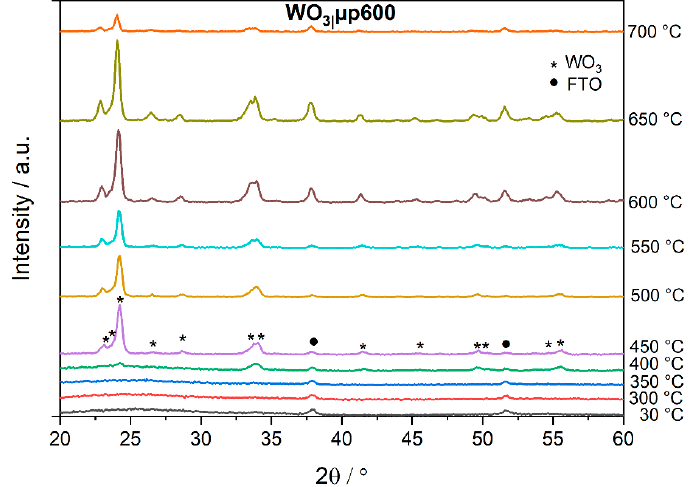
Figure 2. In situ GIXRD patterns of a WO 3| µp600 film that was annealed up to 700 °C with reflexes assigned to triclinic WO 3 (JCPDS: 83-0947) and FTO marked with asterisks and dots, respectively. Thermogravimetry (TG) of the dried precursor, resembling films following spin-coat- ing, was performed to monitor the decomposition of the polymers during heat treatment and to detect possible phase transformations of WO 3 . In Figure 3a, the TG curves for the dried peroxotungstic acid precursor solutions with and without PEG are shown. Starting from room temperature up to a temperature of 100 °C, a small loss in mass of around 1% followed by a larger loss from 100 °C to 200 °C was observed caused by the desorption of water and organic solvents as well as the transformation of peroxotungstic acid to WO 3 [14,27,29]. For the precursors with PEG, mainly its decomposition contributed to this mass loss [27]. As expected, the drop in mass from room temperature to 250 °C is larger for the precursor containing PEG 600 since a larger amount of polymer is present. Within the three hours of treatment at 250 °C, the mass of the precursor without additives decayed by 2% whereas the precursors containing PEG 400 or PEG 600 reduced their mass by only 1% or 0.4%. All three precursors quickly stabilized indicating that keeping them for about 1 h at 250 °C is sufficient for the preparation of amorphous WO 3 thin films. The subsequent small loss of mass (2%) upon further heating to 700 °C can be assigned to the phase tran- sition of amorphous to crystalline WO 3 [14,27,29], which was independently proven by XRD (Figures 2 and S2). The TG curves for the precursors containing the block copolymer PIB 50 - b -PEO 45 or PIB 50 - b -PEO 45 in combination with PEG 600 (Figure 3b) follow the same trend upon heating to 300 °C. At this temperature, however, a mass loss of about 3% was observed over 12 h, indicating continued decomposition of the polymer. Upon subsequent heating to 800 °C, a significant mass loss of another 3% (WO 3| mp) or 7% (WO 3| µmp) was observed consisting of both, crystallization of WO 3 [27] and completion of polymer de- composition in the case of WO 3| µmp. For WO 3| mp, however, the mass loss of the precur- sor is similar to the one of the precursor without any additives confirming that residuals of the polymer were still present in the films. Since amorphous WO 3 thin films were aimed at, a temperature not higher than 300 °C (Figures 2 and S2) had to be chosen for the heat treatment of the films and it cannot be excluded that the WO 3| mp thin films might still contain some polymer fragments. Comparing the initial loss of mass for the different pre- cursors reveal that the precursor without any additives and the one containing PIB 50 - b - PEO 45 have lost about the same amount of mass (15–18%) up to a temperature of 250 °C while the precursors with PEG 600 have lost more than half of their original mass. The reason for the similar decrease in mass for the pure precursor and the one with PIB 50 - b - PEO 45 can be explained by the small polymer content and its only partial decomposition.